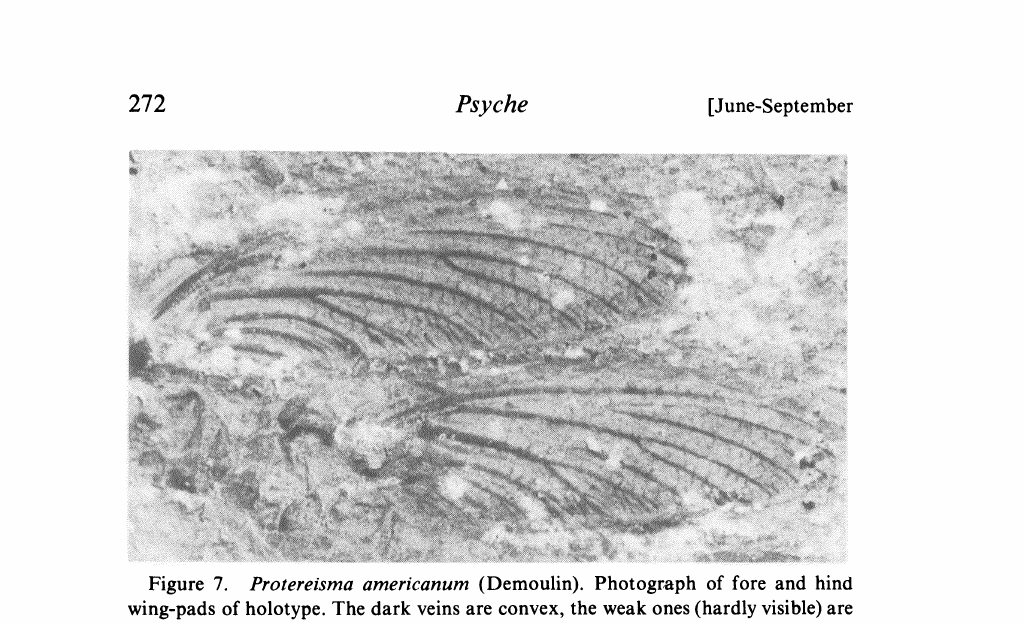
Figure 7. Protereisma americanurn (Demoulin). Photograph of fore and hind wing-pads of holotype. The dark veins are convex, the weak ones (hardly visible) are concave. Length of fore wing-pad, 5.5